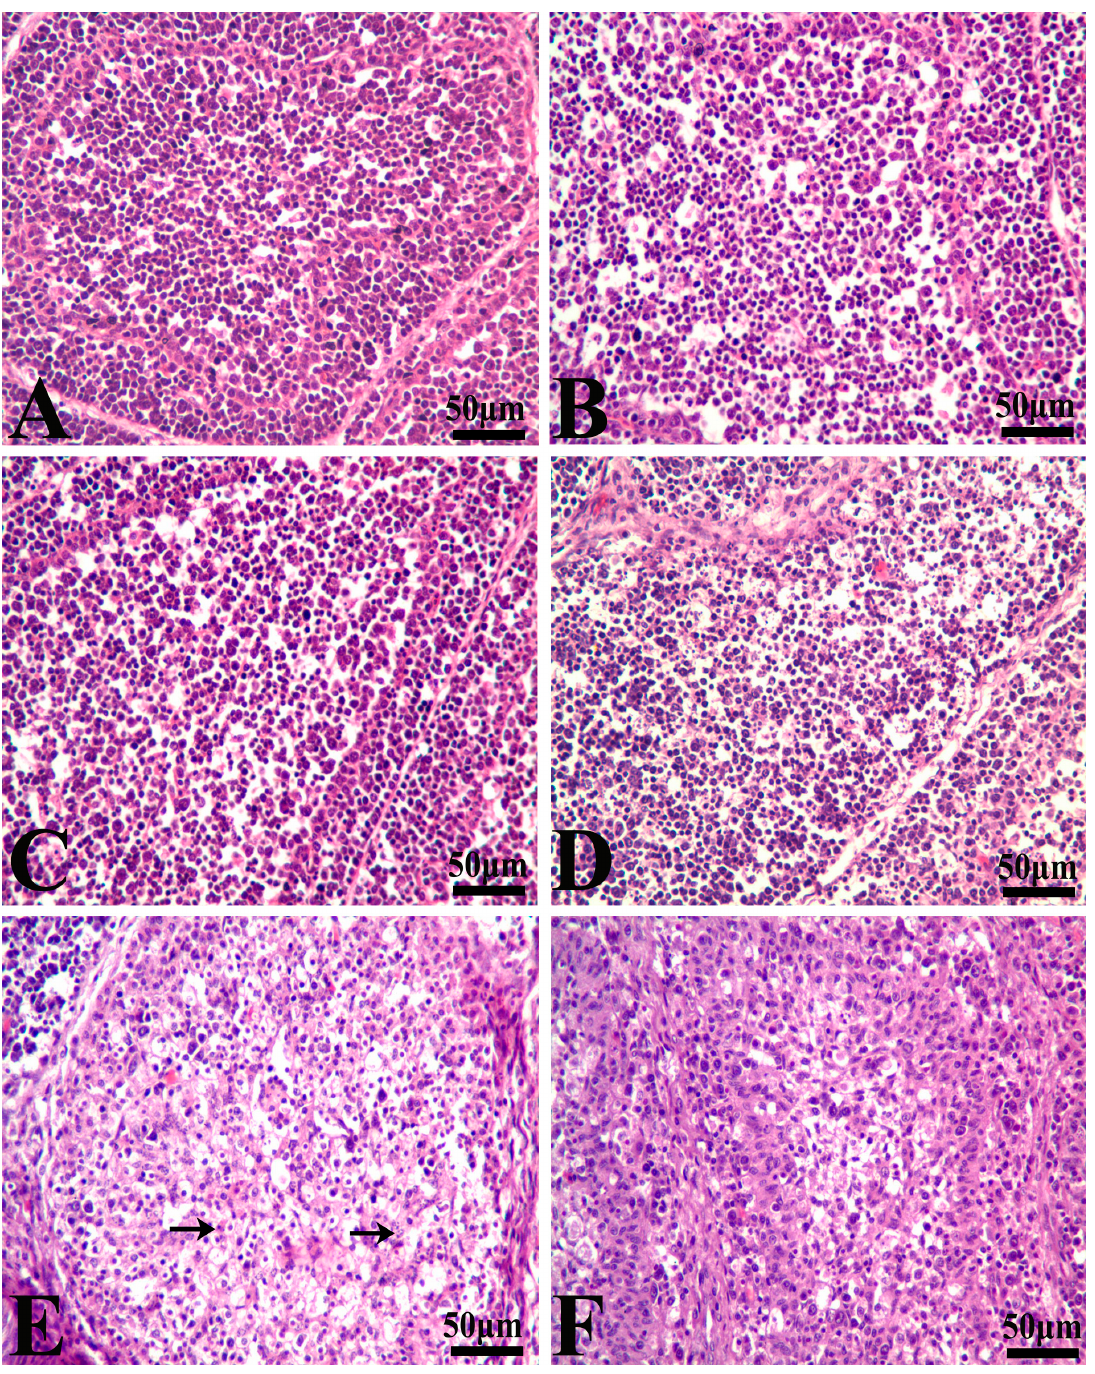
Figure 3. Photomicrographs of hematoxylin- and eosin-stained chicken BF section. At 14 days of age, when compared with that of the control group ( A ), nuclear debris was gradually increased in the BF of chickens in the 50%, 75% and 100% groups ( B – D , respectively). At 21 days of age, histologic lesions became deteriorated. In the 100% group, more nuclear debris ( → ) was observed ( E ). At 42 days of age, the BF in the 100% groups still showed decreased lymphocytes and increased reticulocytes and fibroblasts ( F ). Bars = 50 µm.